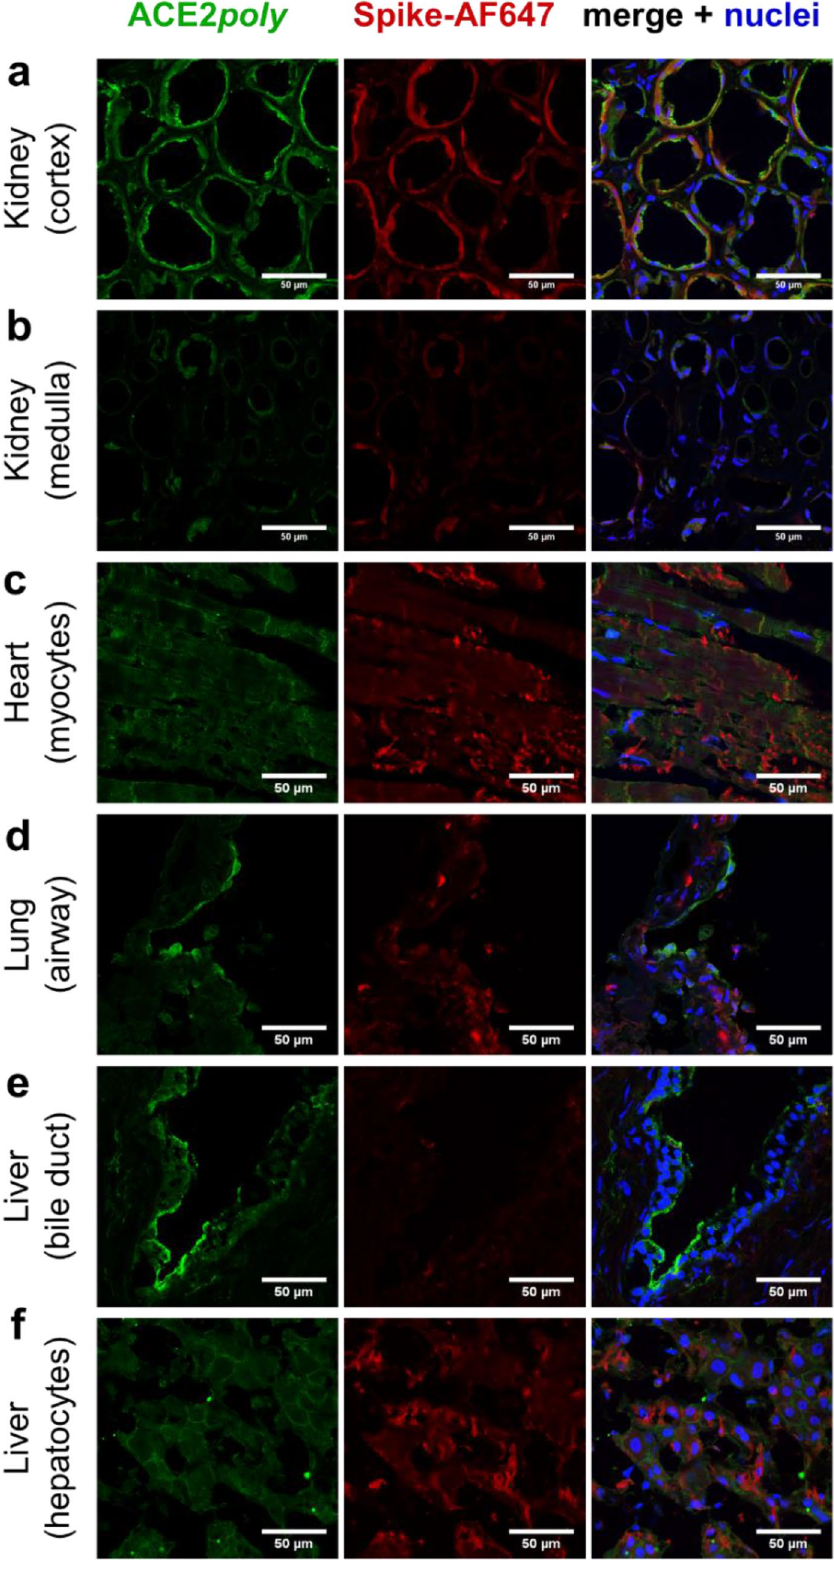
Figure 5. Binding of fluorescent SARS-CoV-2 spike-AF647 in ACE2 positive cells in a panel of human tissues. Representative confocal fluorescent images (n ≥ 2 independent donors, stained in duplicate) of human tissue fixed in 4% formaldehyde and treated with ACE2 poly (left column, visualised in green) and 1 µM spike-AF647 (centre column, visualised in red). Merged images (right column, overlay) also include Hoechst 33342 nuclear marker (visualised in blue). Scale bars are as indicated in figure. Tissues shown include: ( a ) Kidney cortex; ( b ) Kidney medulla; ( c ) Left ventricle heart tissue, showing cardiomyocytes; ( d ) Lung tissue, showing an airway structure; ( e ) Liver bile duct; ( f ) Liver